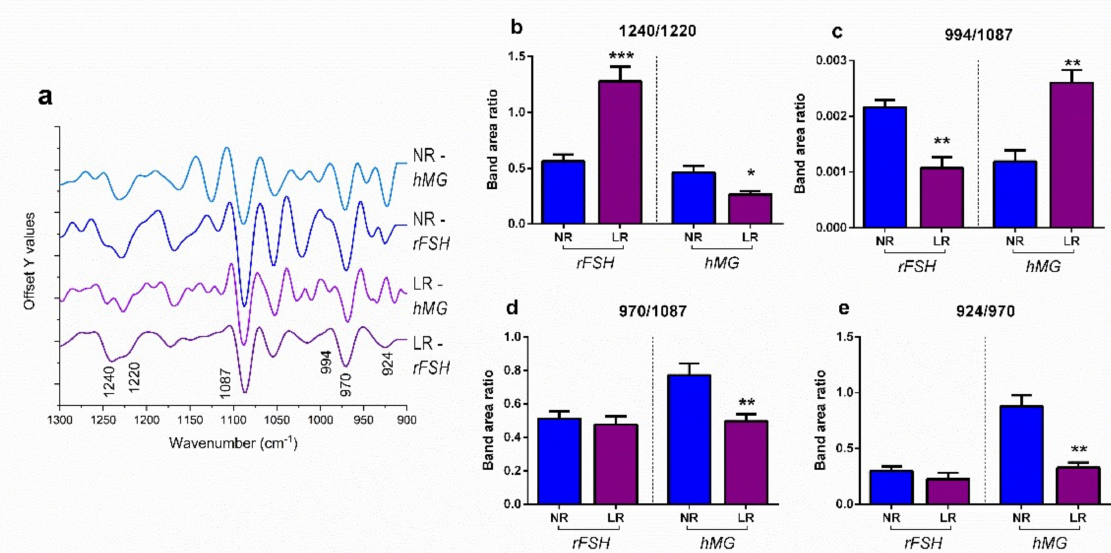
Figure 8. ( a ) Average spectra of NR and LR groups, treated with rFSH and hMG, reported in second derivative mode (1300–900 cm − 1 ); the wavenumbers of the most relevant peaks are labelled at the bottom. Results of Student’s t -test on band area ratios ( b ) 1240/1220, ( c ) 994/1087, ( d ) 970/1087, and ( e ) 924/970. Histograms show the values of the band area ratios obtained by curve fitting procedure on mean spectra and the mean ± standard deviation spectra of NR and LR groups, treated with rFSH and hMG. Data are reported as mean ± standard deviation. Statistical significance was set at p < 0.05 and calculated by Student’s t -test. Asterisks above columns indicate a statistically significant difference between NR and LR groups. * = p < 0.01; ** = p < 0.01; *** = p <